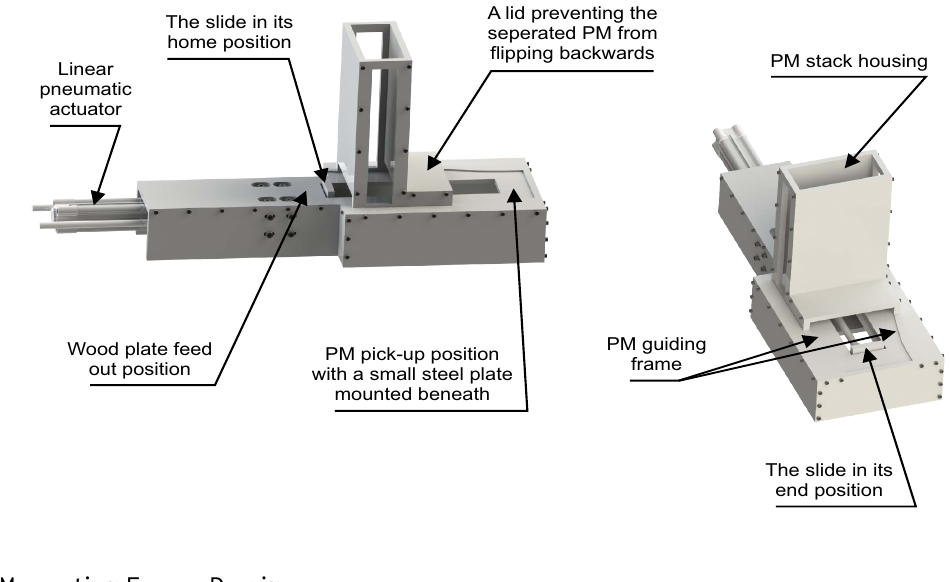
Figure 6. The developed PM delivery station design and its main